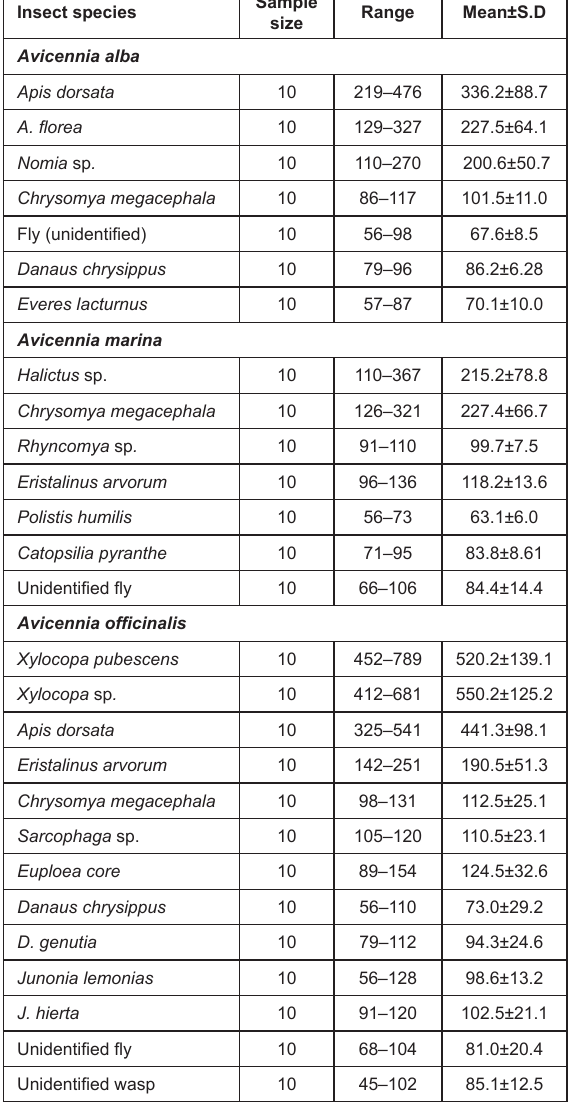
Table 2. Pollen pick up efficiency of foraging insects on Avicennia